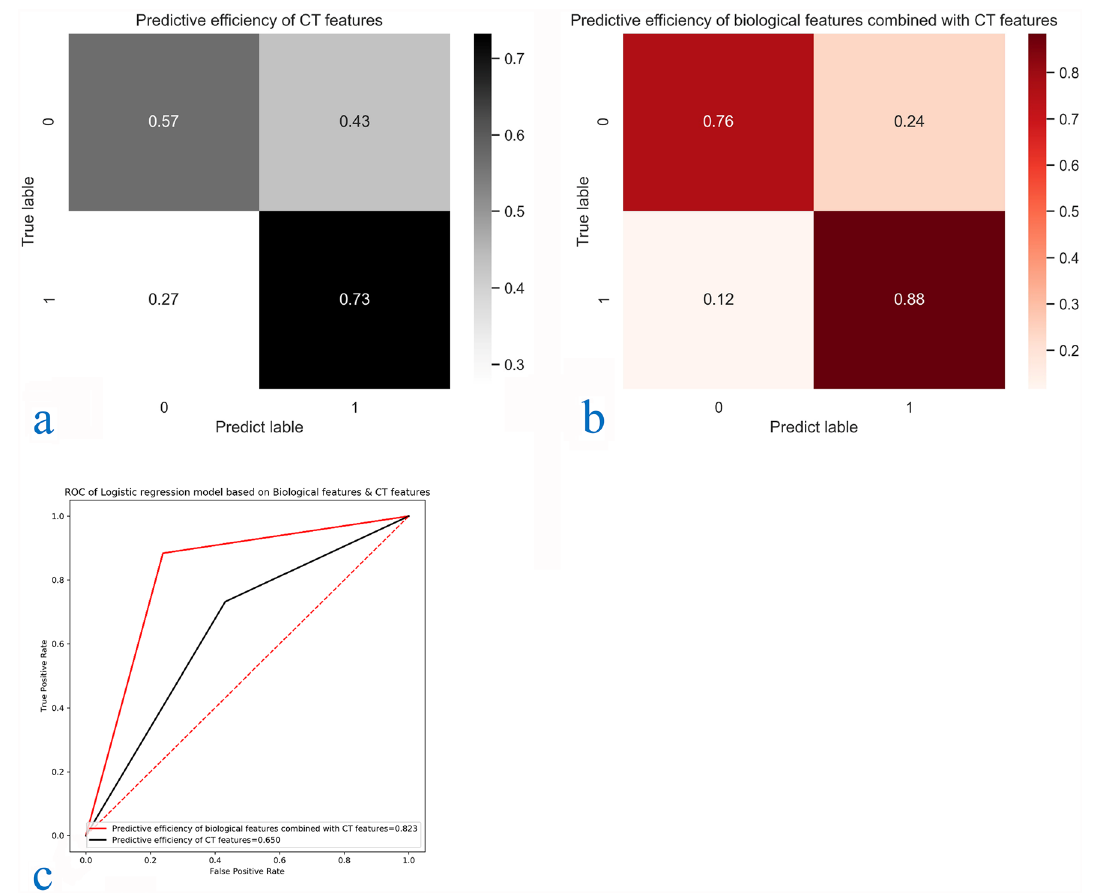
Figure 7. ( a – c ) Confusion matrix and ROC curve of CT features classification results and biological characteristics combined with CT features classification results.